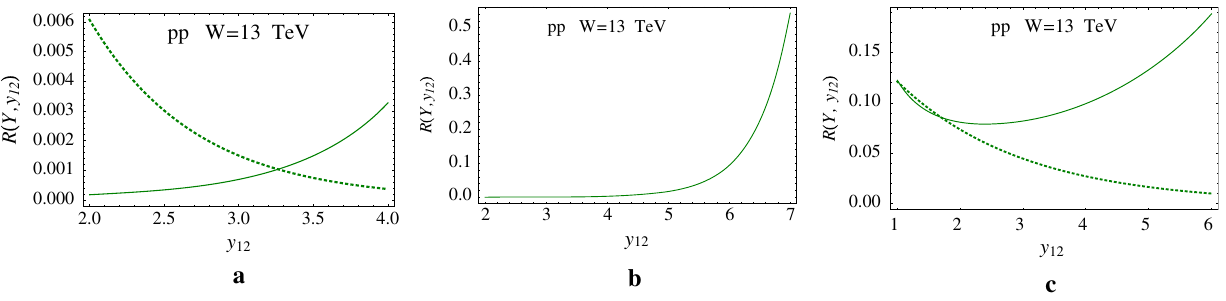
in the leading order of perturbative QCD with ¯ α S = 0 . 25. In c we take (cid:8) ( Y − y ) . = 0 . 25 and Q 2 ( Y ) ∝ exp (λ Y ) with λ = 0 . 25. These numbers 12 BFKL s 2 correspond to the BFKL